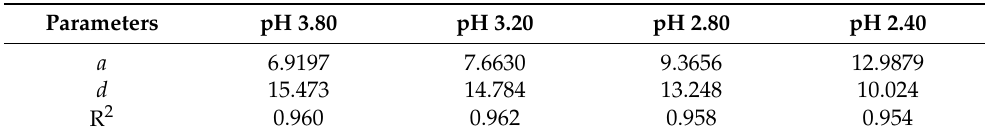
Table 2. Parameters of the exponential decay model for RB5 dye removal by original fique fibers using different solution pH values.